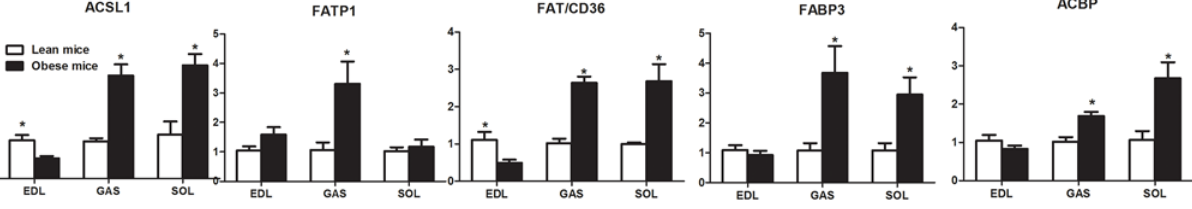
Fig 4. Comparative study of the mRNA expression of ACSL1, FAT, ACBP, FABP3, and FATP1 in the EDL, GAS and SOL between lean and obese mice. The data are presented as the mean ± SEM (n = 3). Asterisks ( * ) indicate significant differences between lean and obese mice ( P < 0.05). ACSL, long- chain fatty acyl-CoA synthetase; FAT, fatty acid translocase; ACBP, acyl CoA binding protein; FABP, fatty acid binding protein; FATP, fatty acid transport protein, EDL, extensor digitorum longus; GAS, gastrocnemius; SOL, soleus.